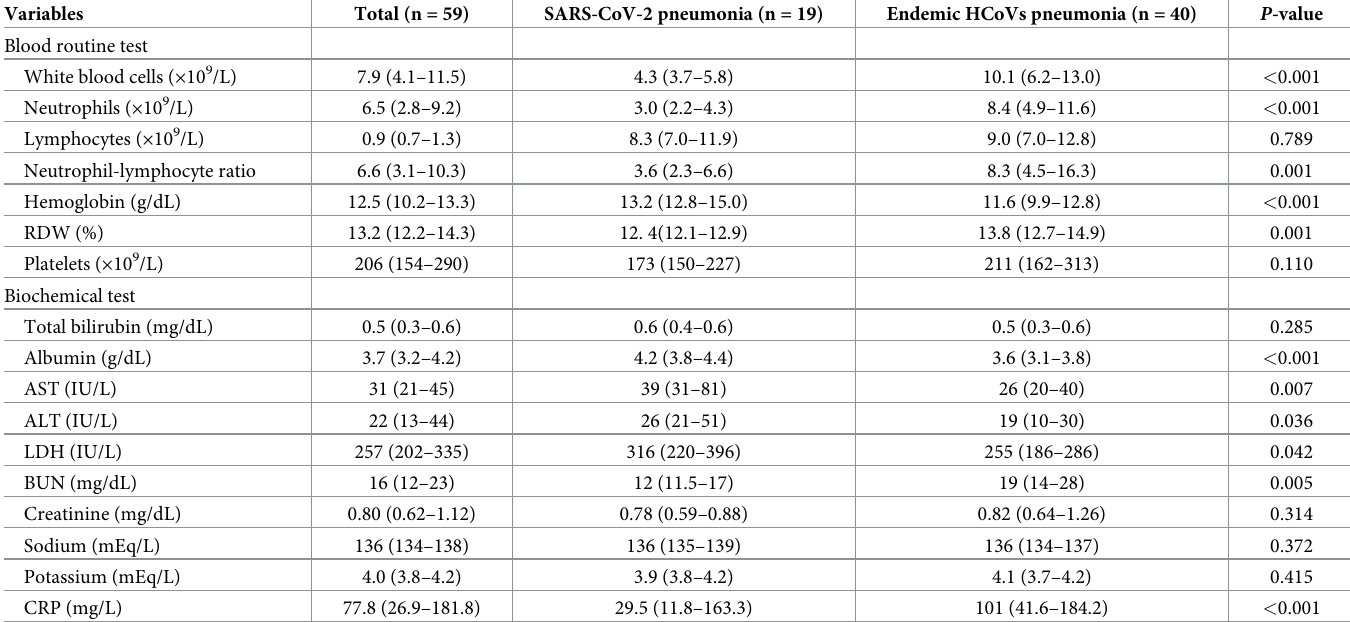
Table 2. Laboratory findings and chest imaging of the